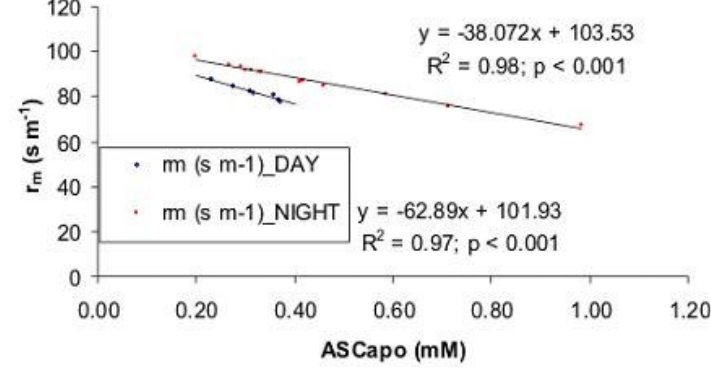
FIGURE 7. Regression for mesophyll resistance (r m ) and reduced apoplastic ascorbic acid (ASC apo ) for night-time (upper line, O 3 reacted (%)_NIGHT; n = 10) and day-time hours (lower line, O 3 reacted (%)_DAY; n =